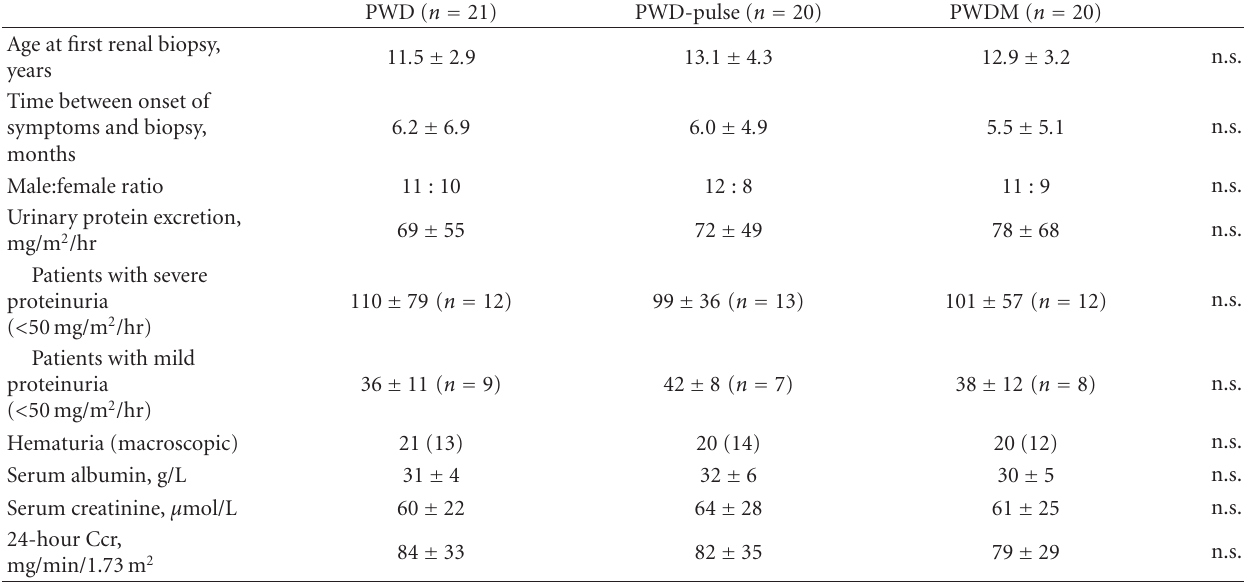
Table 2: Comparison between patient characteristics and laboratory findings in the three groups at the time of the first renal